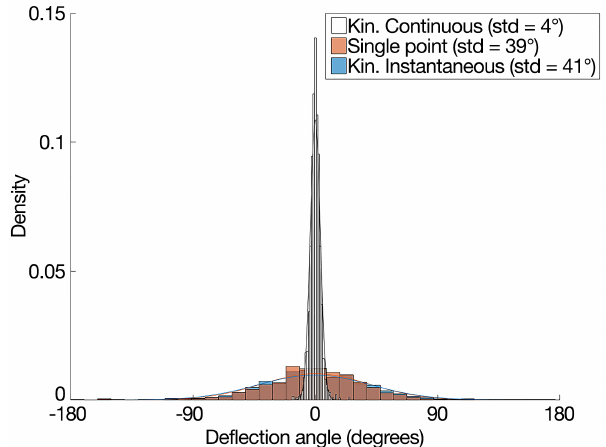
Figure 9. Histogram of the deflection angles.